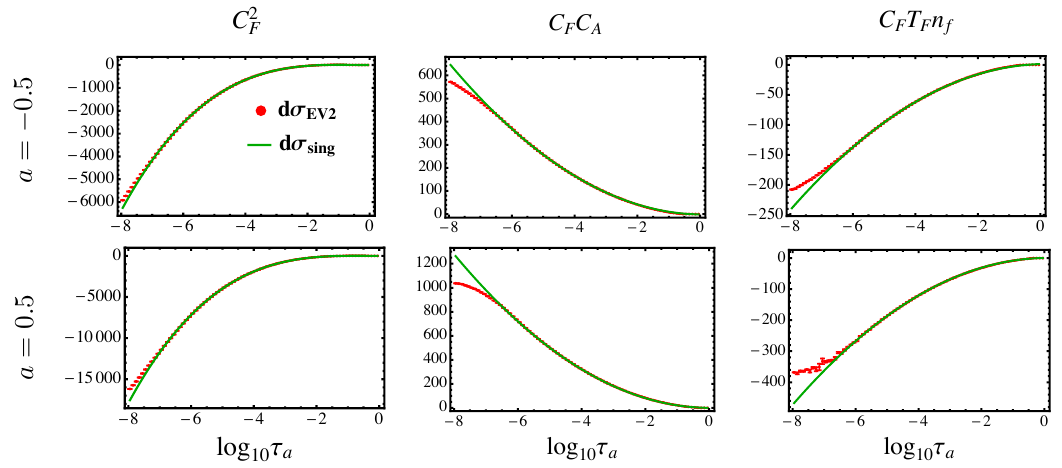
Figure 5 . Comparison of the EVENT2 prediction for two angularity distributions at analytically-known singular terms that follow from eq. (3.6). The plots show the coe(cid:14)cients of the color structures C 2 , C F C A , C F T F n f F